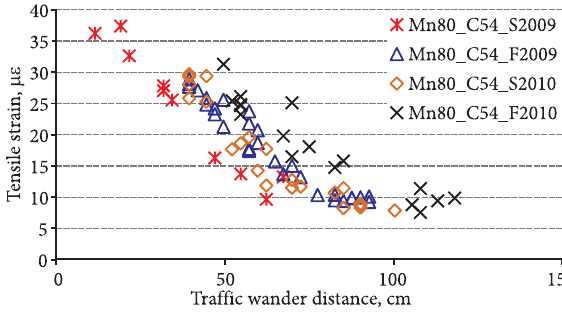
Fig. 5. Effect of testing seasons and traffic wander on tensile strains at the bottom of the PCC slab near mid-slab